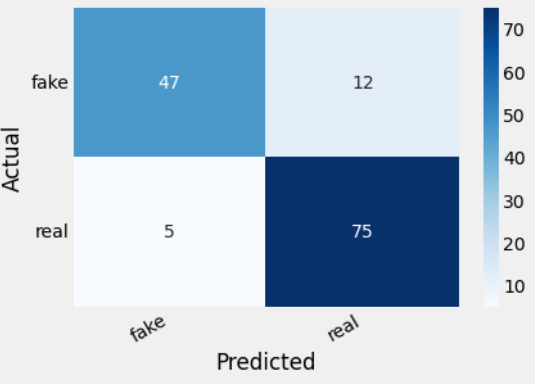
Figure 12. Confusion matrix of BERT base -CNN-BiGRU-ATT in PolitiFact w/o user posting behavior features.